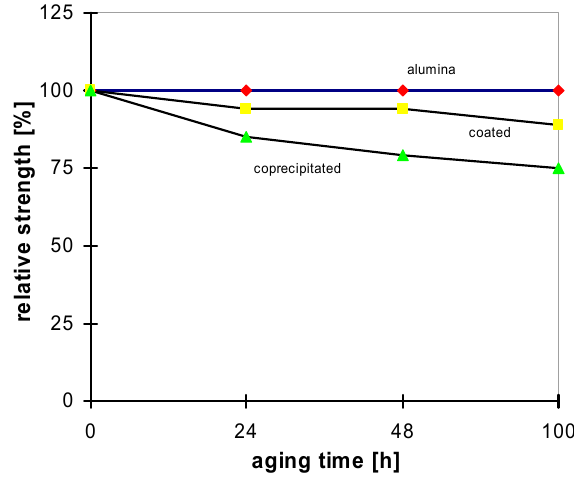
Figure 18. Strength decrease of Y-TZP after hydrothermal treatment.